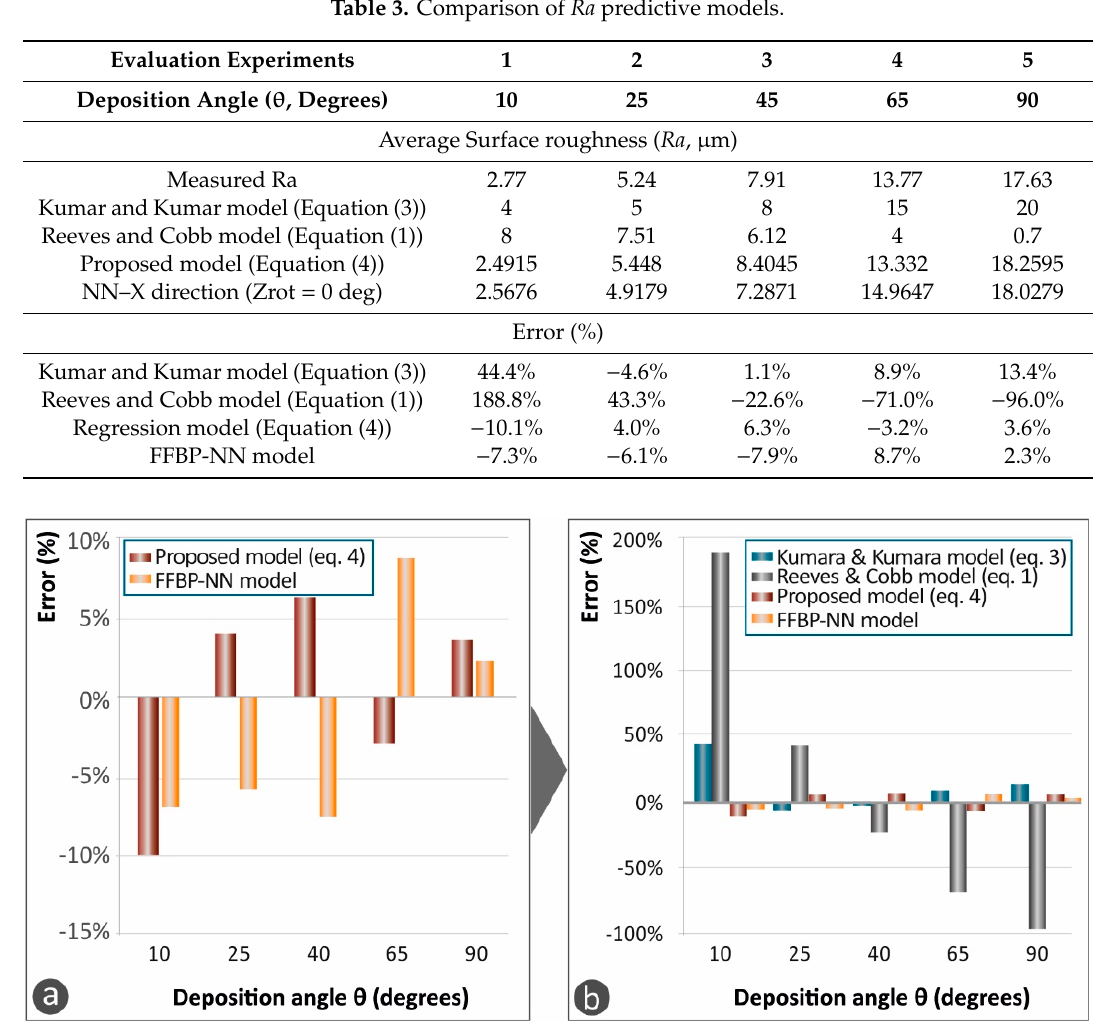
Figure 10. ( a ) Error of Ra for the prediction models (Table 3); ( b ) comparison of the Ra error between the prediction models and the